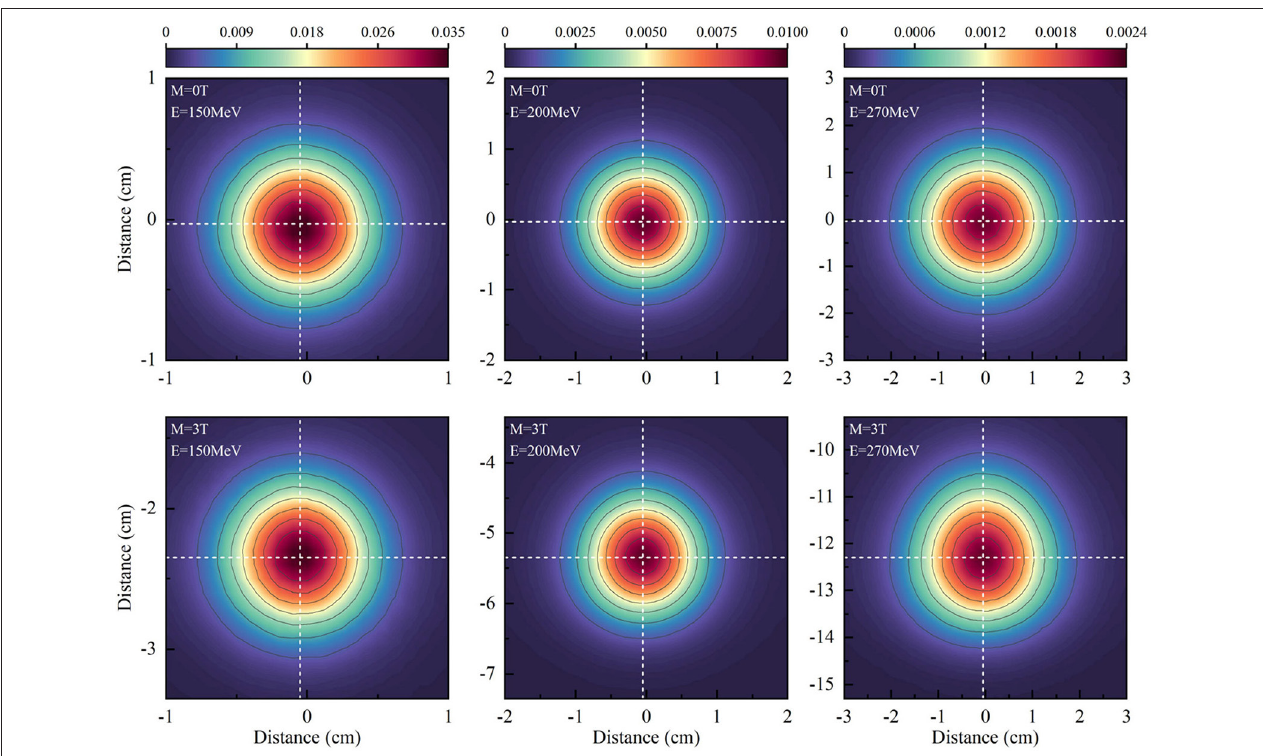
FIGURE 3 | Shows the planar dose distributions at the Bragg-peak positions for protons without magnetic fields at the panels and under a field strength of 3.0 Tesla.